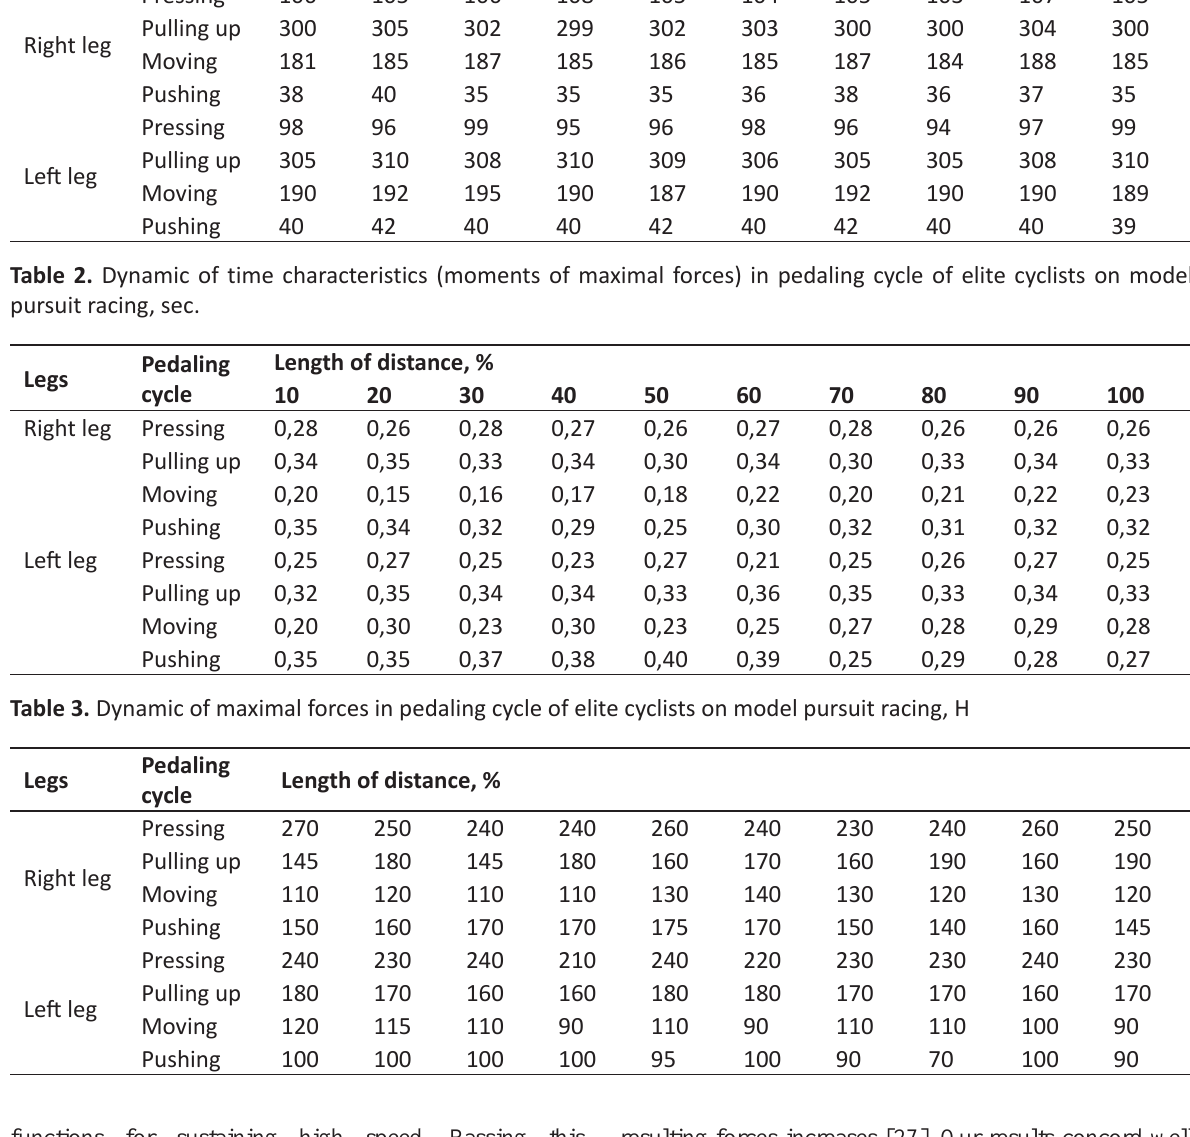
Table 1. Dynamic of space characteristics (moments of maximal forces) in pedaling cycle of elite cyclists on model pursuit racing, degrees Pedaling Legs cycle Pressing Pulling up Right leg